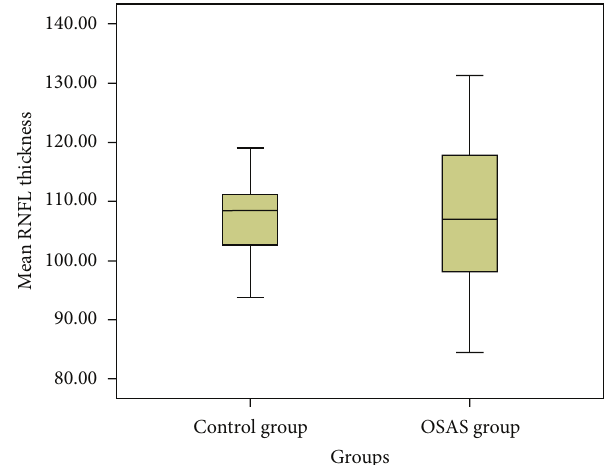
Figure 1: The distribution of average retinal nerve fiber layer thick- ness(RNFL)thicknessinObstructivesleepapneasyndrome(OSAS) and control